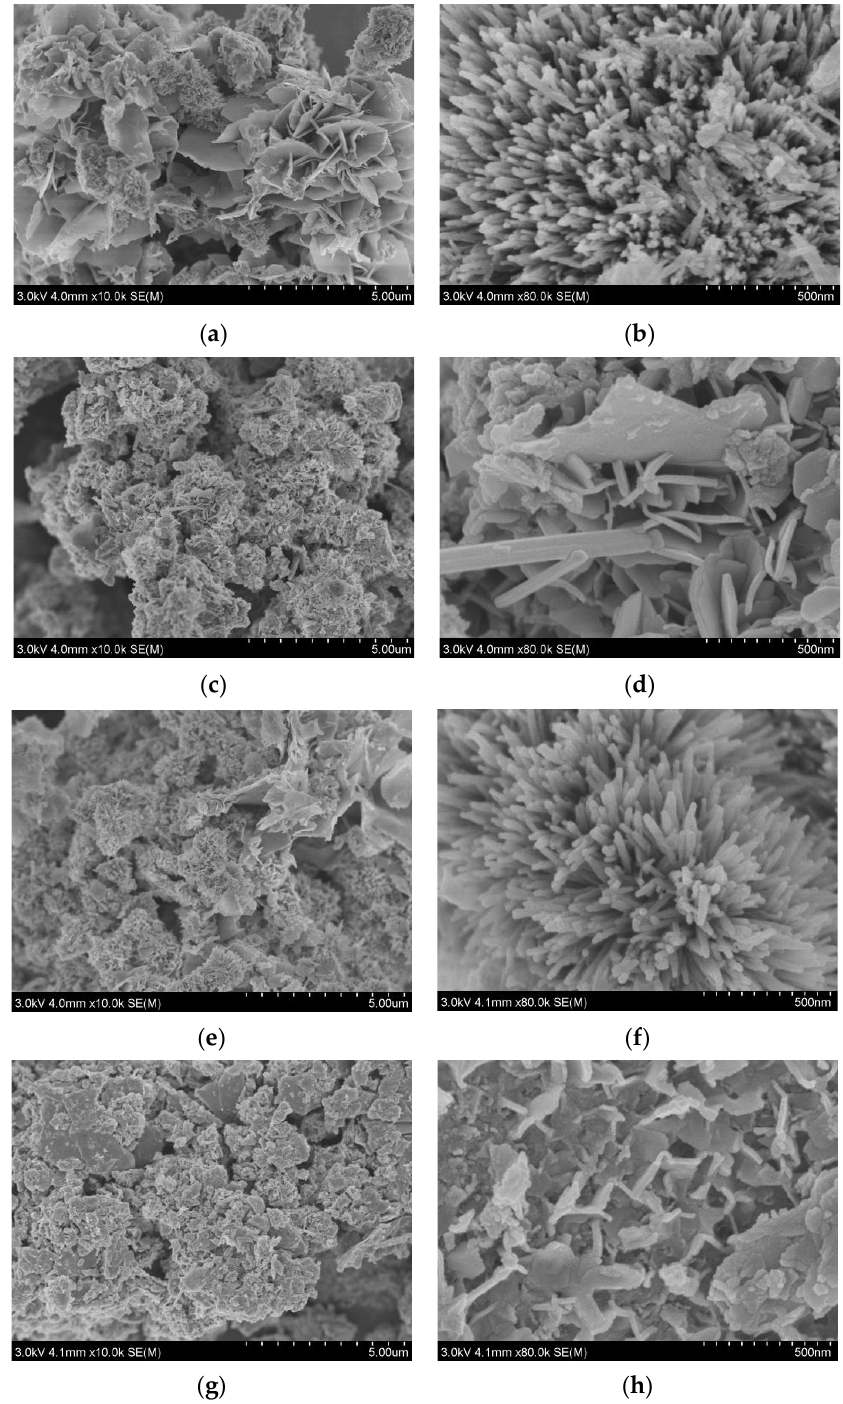
Figure 2. SEM images of ( a , b ) NFM LDH, ( c , d ) NFM LDH/OOH, ( e , f ) NFM LDH-G, ( g , h ) NFM LDH/OOH ‐ G.